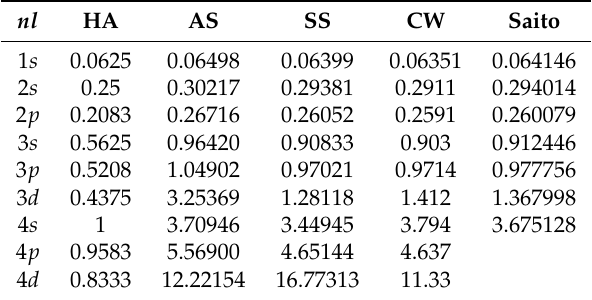
Table 3. Comparing the values of (cid:104) r (cid:105) calculated by the Hydrogenic approximation (HA) and by the AS, SS, and CW atomic structure codes with values calculated by Saito 2009 [13] in a.u.